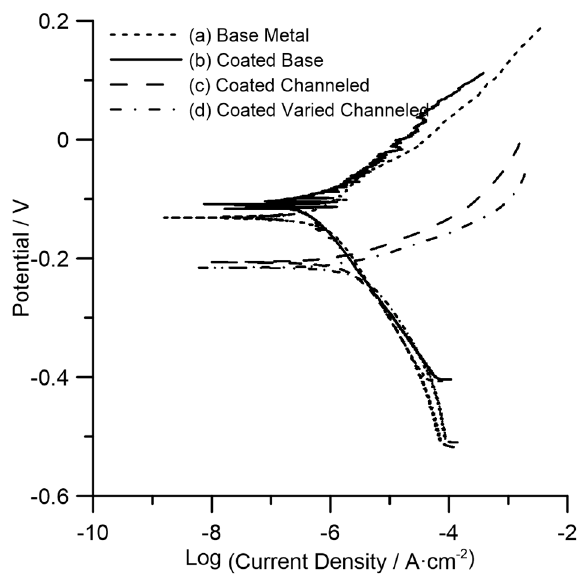
Figure 7. Tafel plot comparison among the ( a ) base metal; ( b ) coated base; ( c ) coated channeled and ( d ) coated varied channeled surfaces.